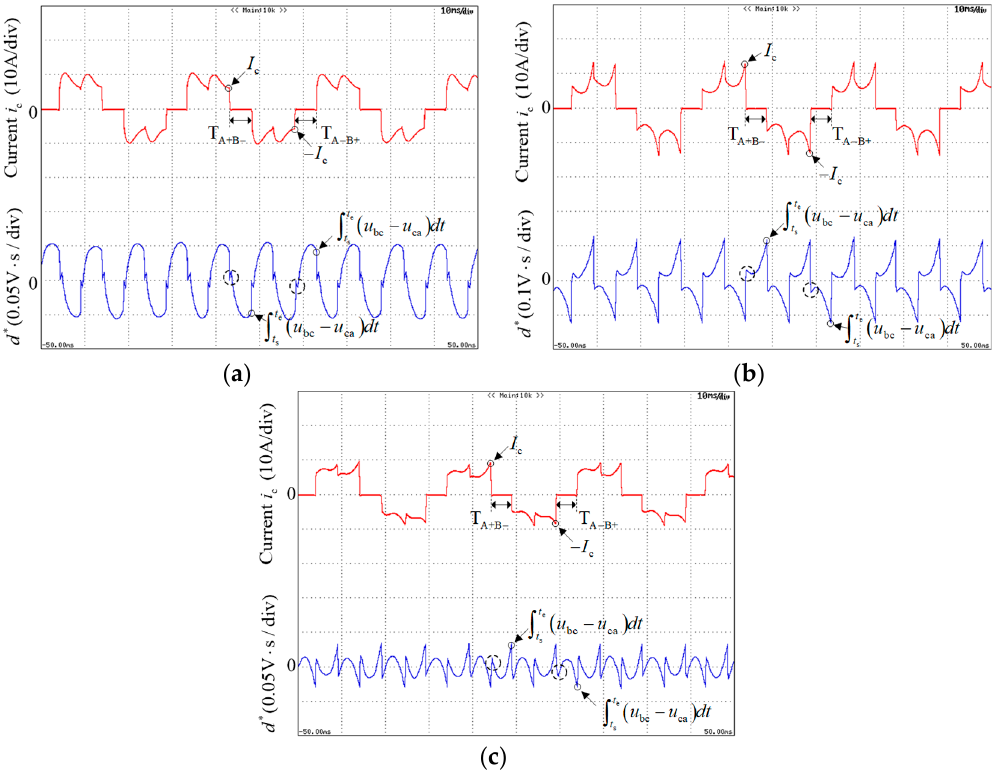
Figure 12. Phase current and the line voltage difference integral. ( a ) Advanced commutation; ( b ) Delayed commutation; ( c ) Exact commutation.